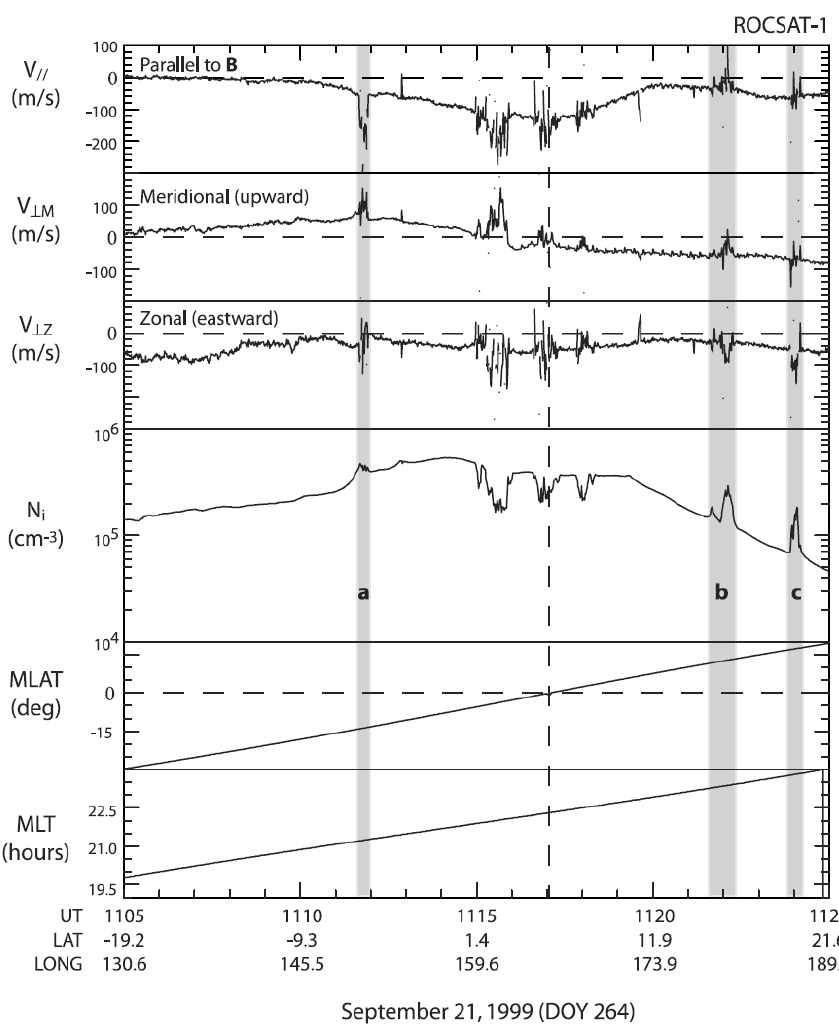
Fig. 8. Data from ROCSAT-1 at altitude 600km on 21 September 1999: field-aligned ion velocity V k , vertical (meridional) perpendicular ion velocity V ⊥ M , zonal perpendicular ion velocity V ⊥ Z , electron density N , magnetic latitude, and local time plotted versus universal time and longitude. From Le et al.